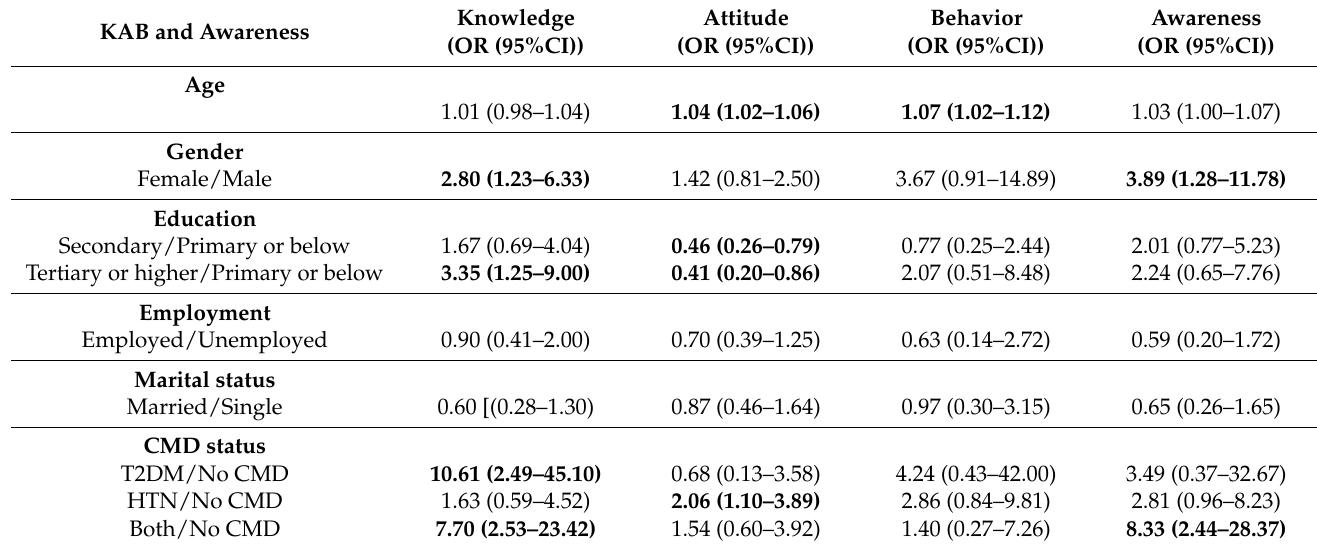
Table 3. Associations of sociodemographic characteristics with knowledge, attitude, behavior, and awareness of car- diometabolic